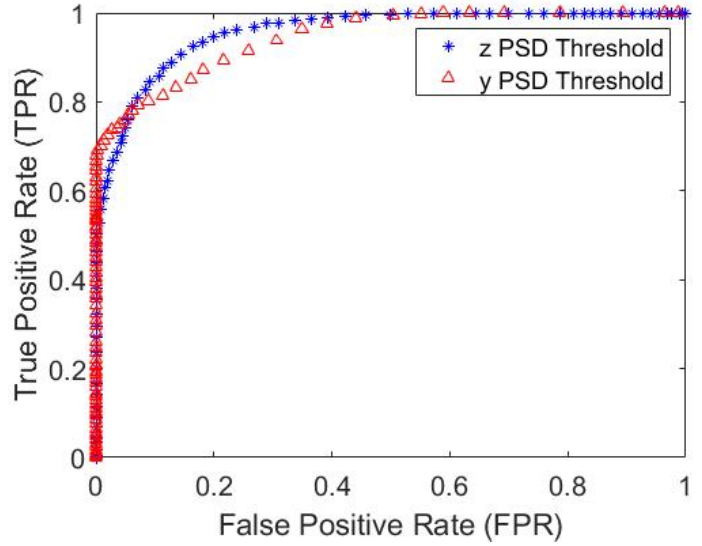
Figure 11. An ROC plot for predicting a defect at any point along the weld using Z ‐ axis and Y ‐ axis PSD threshold. The Y ‐ axis displays the of true ‐ positive rate and the X ‐ axis displays the false ‐ positive rate. The most ideal thresholds performance, would be the point closest points to the top left corner of the plot. These curves were made from the example weld in Figure 2.